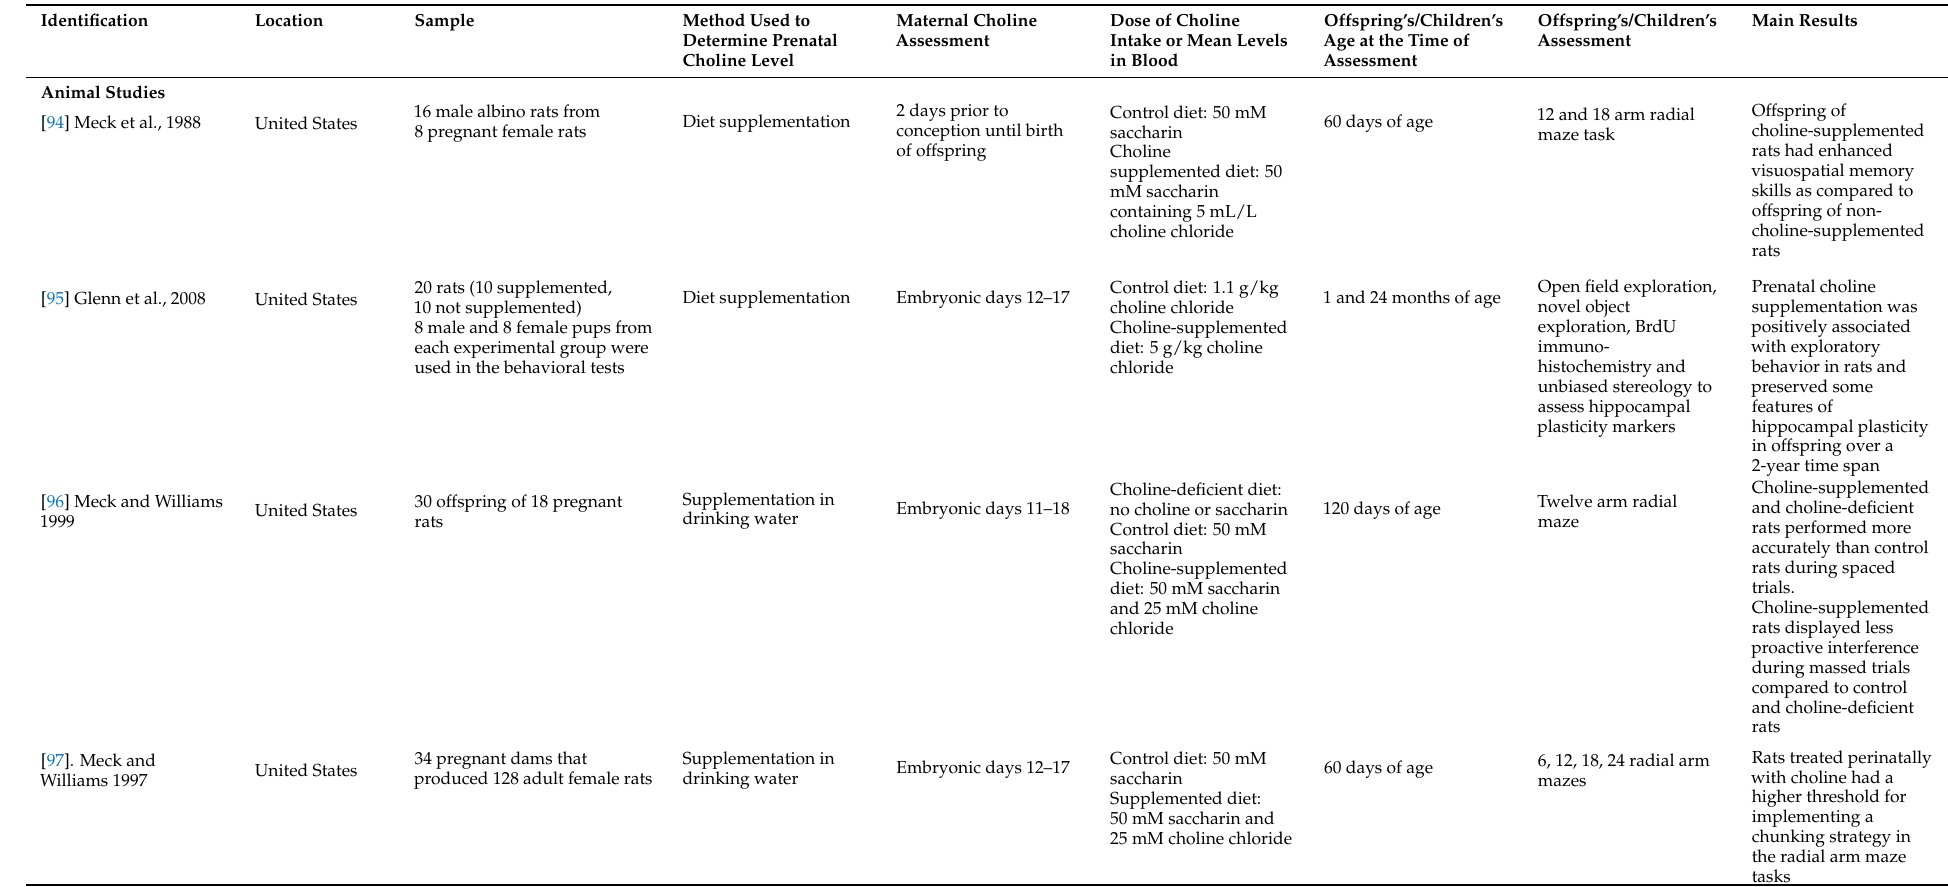
Table 2. Characteristics of the animal and human studies that examined the associations between maternal prenatal choline and offspring cognitive